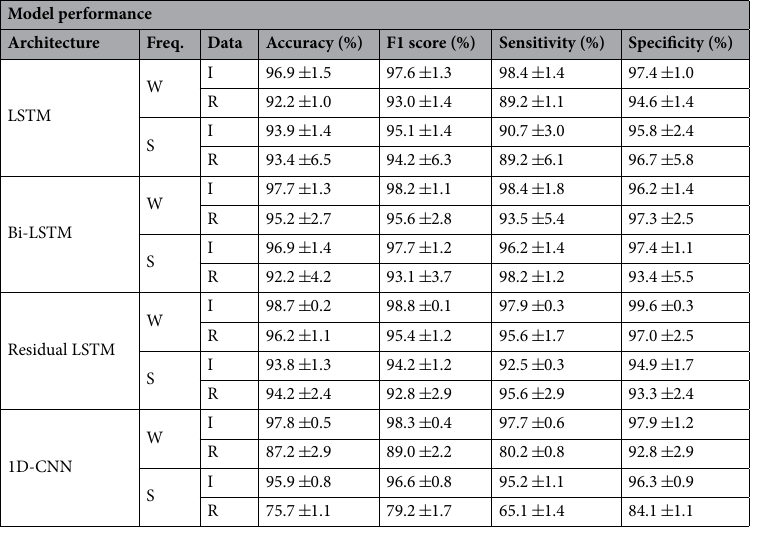
Table 2. Model performance for classifying viable and non-viable small intestine segments after different degrees of ischemic injury. Binary classification classes are divided as following for both ischemic and reperfusion data: class 1: ischemic condition for 1, 2, and 3 h, class 2: ischemic condition for 4–8 h. Both average and standard deviation from 5-fold cross validation are shown in the table. “W” = Whole, indicates that the whole frequency range was used (200 MHz–14 GHz). “S” = Selected, indicates that the selected frequency range was used (6 GHz–14 GHz). “I” = Ischemia and “R” = Reperfusion.